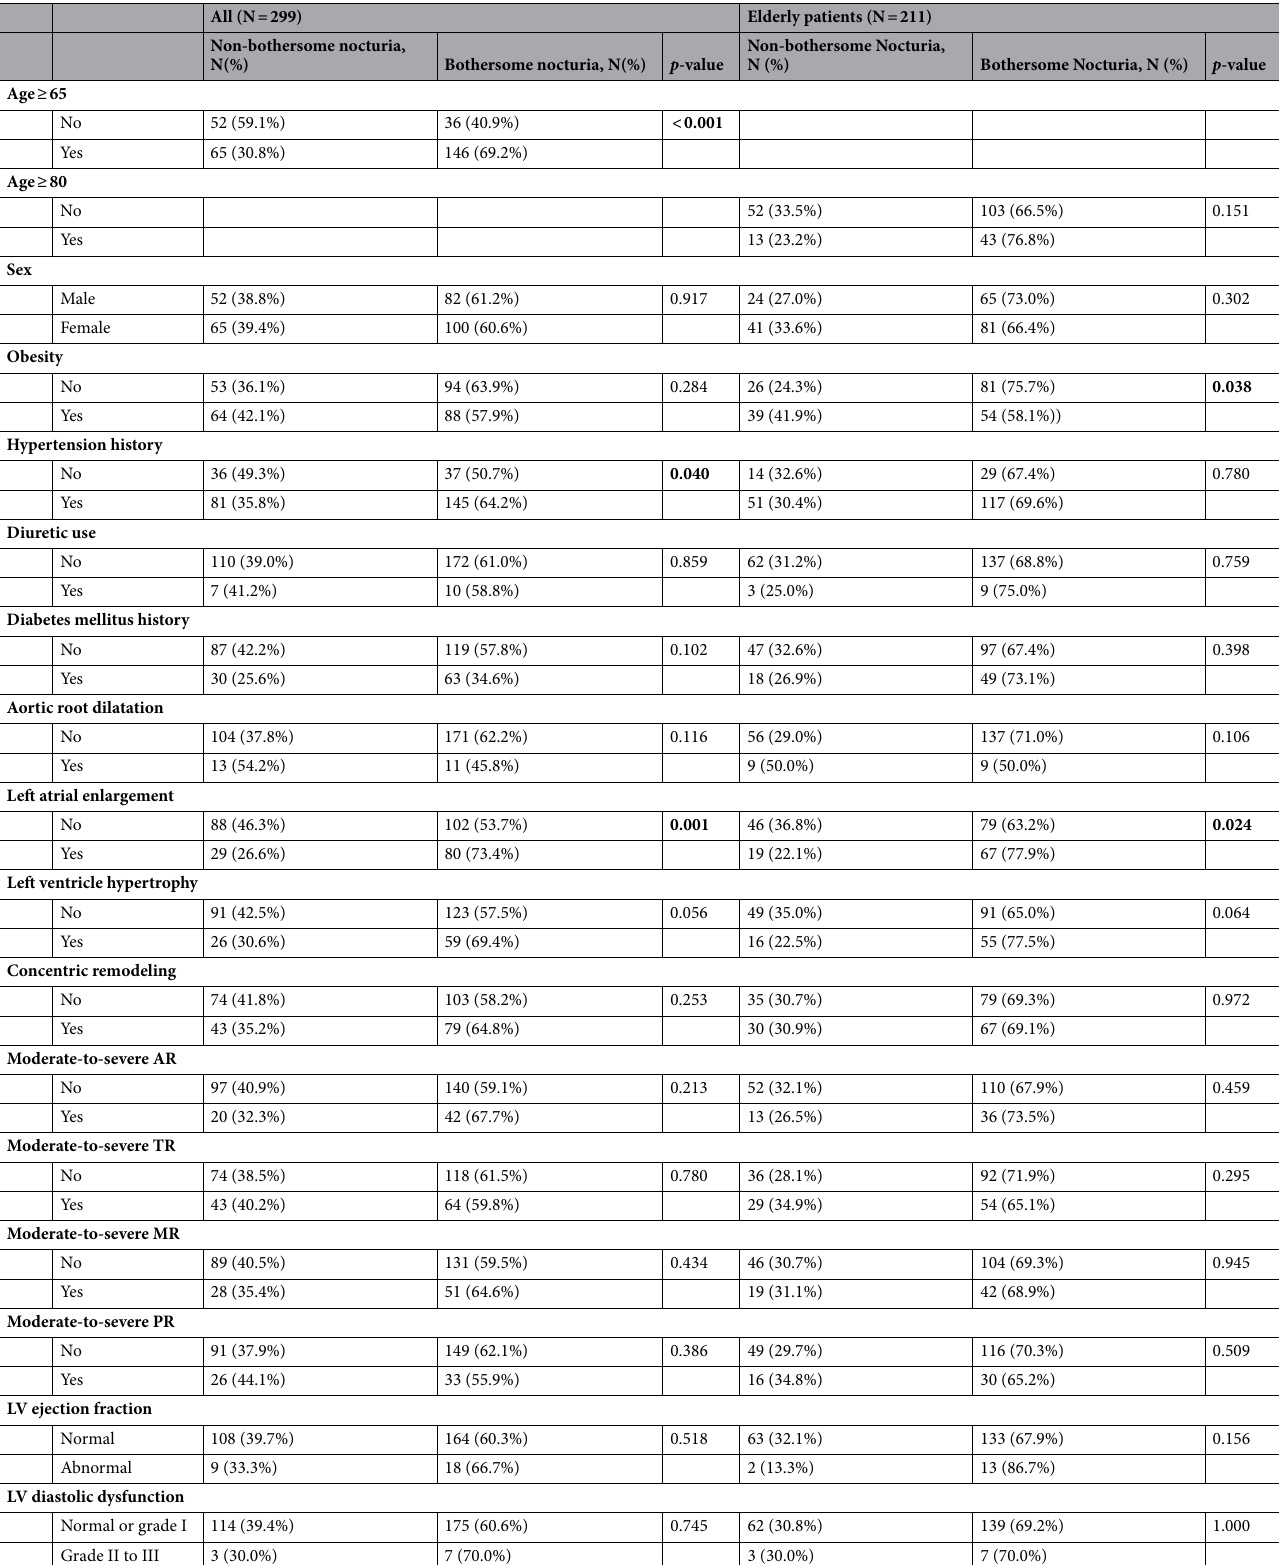
Table 2. Difference in the prevalence of bothersome nocturia among all patients and elderly patients (≥ 65 years). AR aortic valve regurgitation; TR tricuspid valve regurgitation; MR mitral valve regurgitation; PR pulmonary valve regurgitation; LV Left